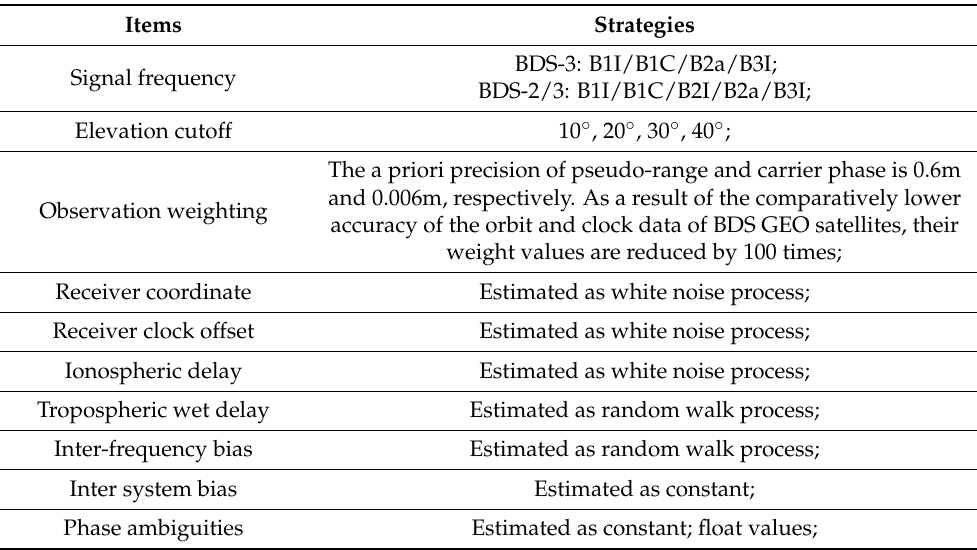
Table 2. Mixed multi-frequency UDUC BDS-2/3 PPP